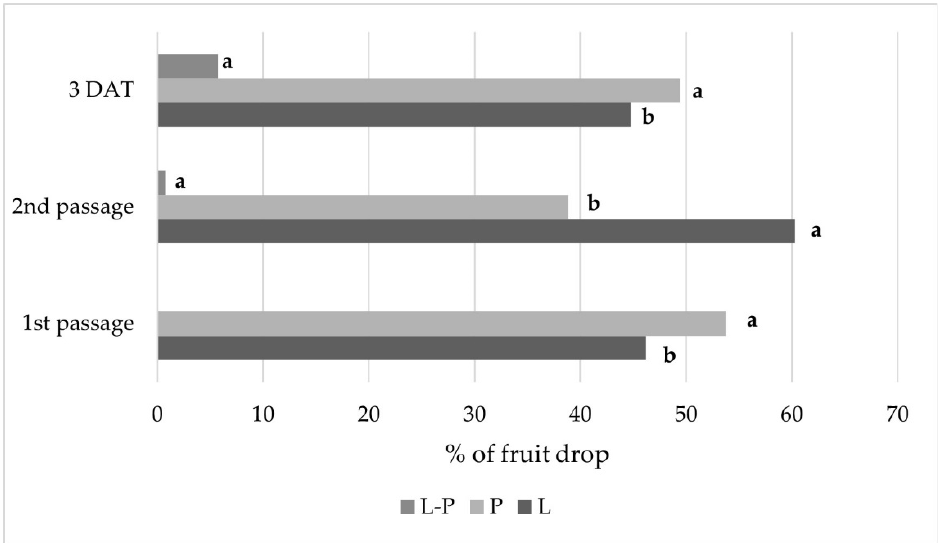
Figure 6. Thinner efficiency at the first and second passage and 3 days after thinning, in relation to insertion of branches on the main stem: longitudinal (L), perpendicular (P), or intermediate (L ‐ P). Means followed by the same letter do not differ significantly at p ≤ 0.05 according to Duncan’s test. Statistical comparisons were carried out within each branch category.